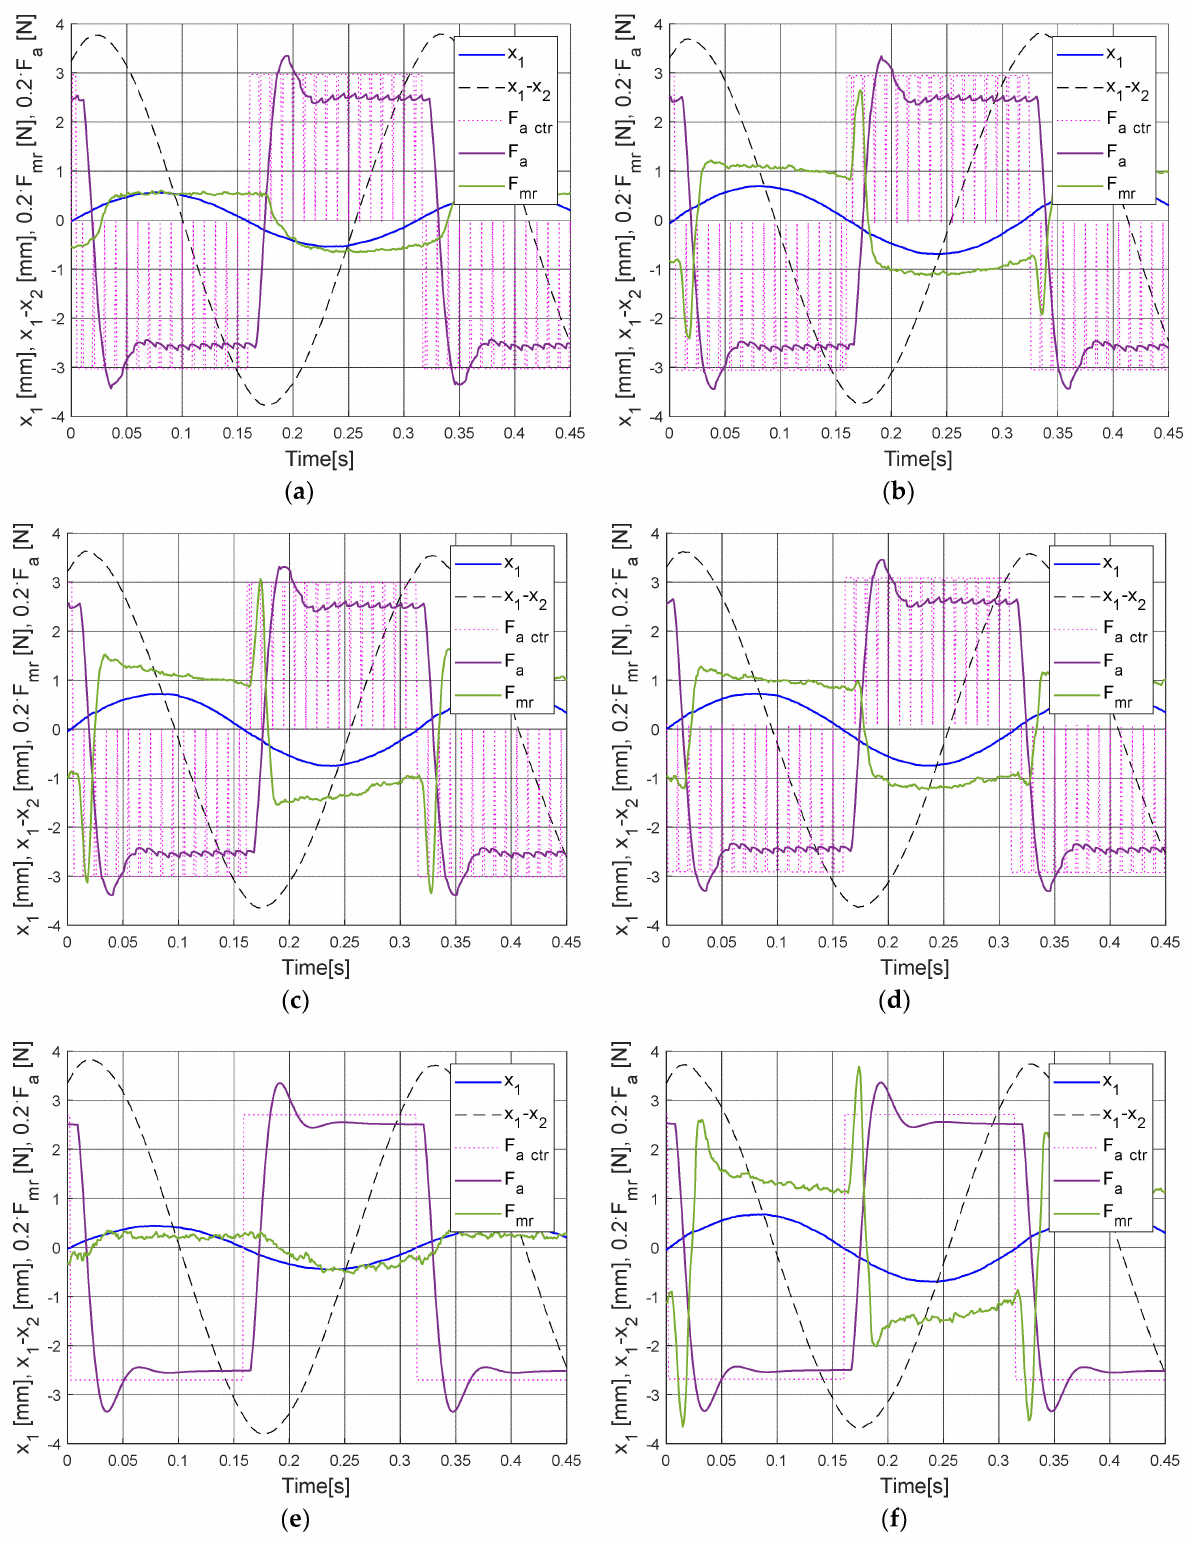
Figure 18. Time responses at 3.2 Hz: ( a ) OPT , i max = 0 ( b ) OPT , i max = 0.5 A ( c ) OPT , i max = 1.0 A, ( d ) OPT , i max = 1.0 A, g 221 = 10 6 , ( e ) GH , i max = 0, ( f ) GH , i max = 1.0 A ( F nom = 12.5